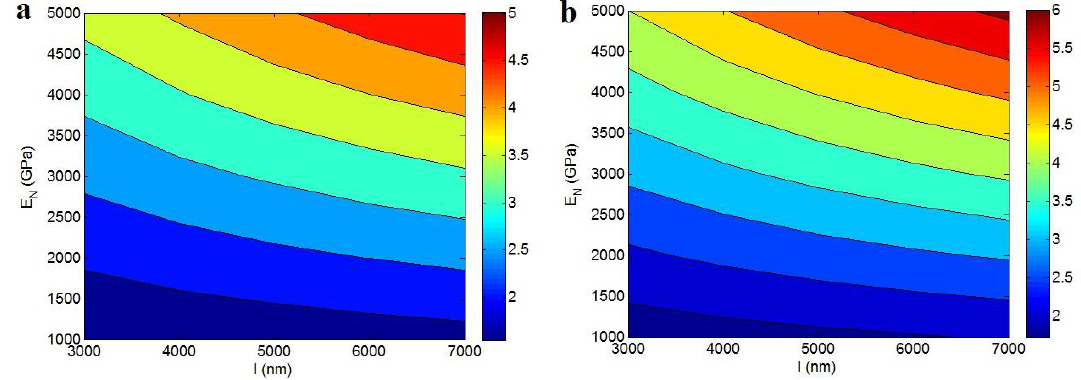
Figure 2. Contour plots for “ l ” and “ E N ” roles in the relative modulus by advanced Takayanagi model at ( a ) t = 5 nm and ( b ) t = 15 nm ( E m = 2 GPa, φ f = 0.02, R = 10 nm, E f = 1000 GPa, A =